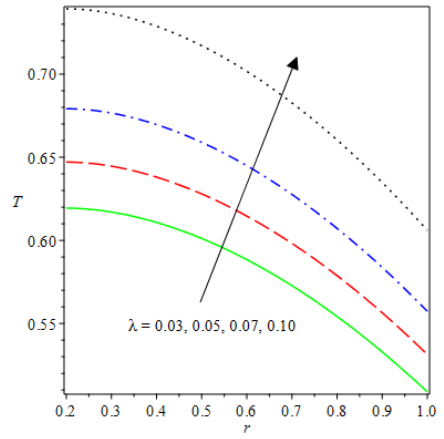
Figure 10. Temperature profile for rising ( λ ) .